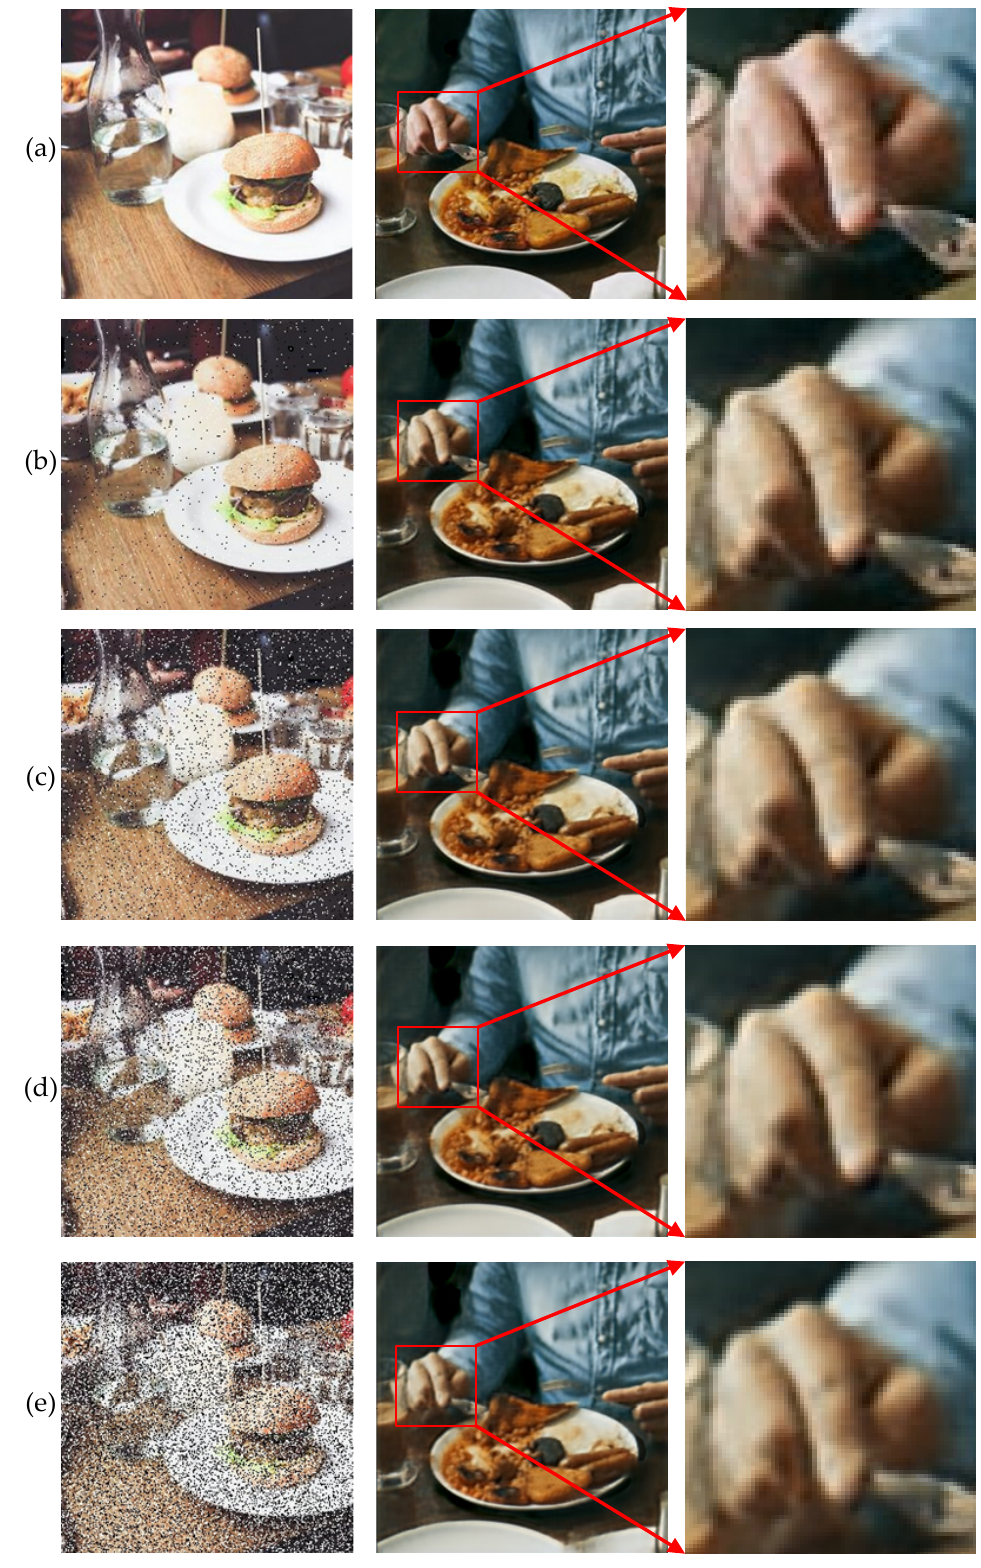
Figure 11. Recovery results of secret images with different intensities of salt-and-pepper noise added to container images: ( a ) 0, ( b ) 0.01, ( c ) 0.05, ( d ) 0.1 and ( e ) 0.2 dBW. From left to right correspond to containers, reconstructed secret images and magnified hand areas in the reconstructed images, respectively.